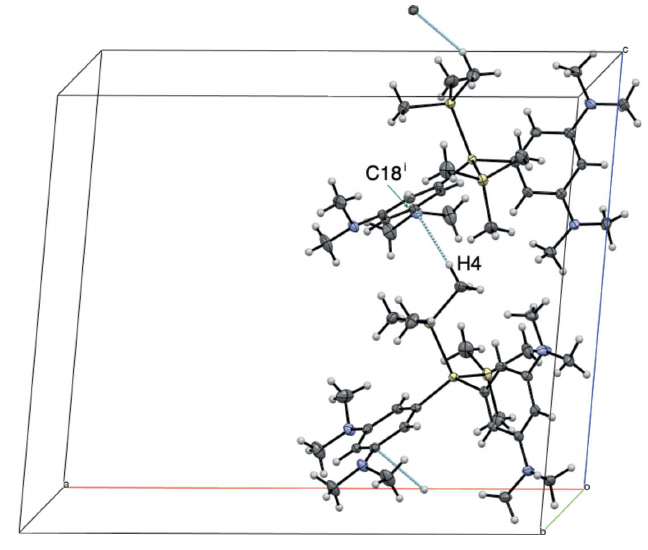
Figure 1 The molecular structure of the title compound, showing displacement ellipsoids at the 50% probability level. Hydrogen atoms are omitted for clarity.